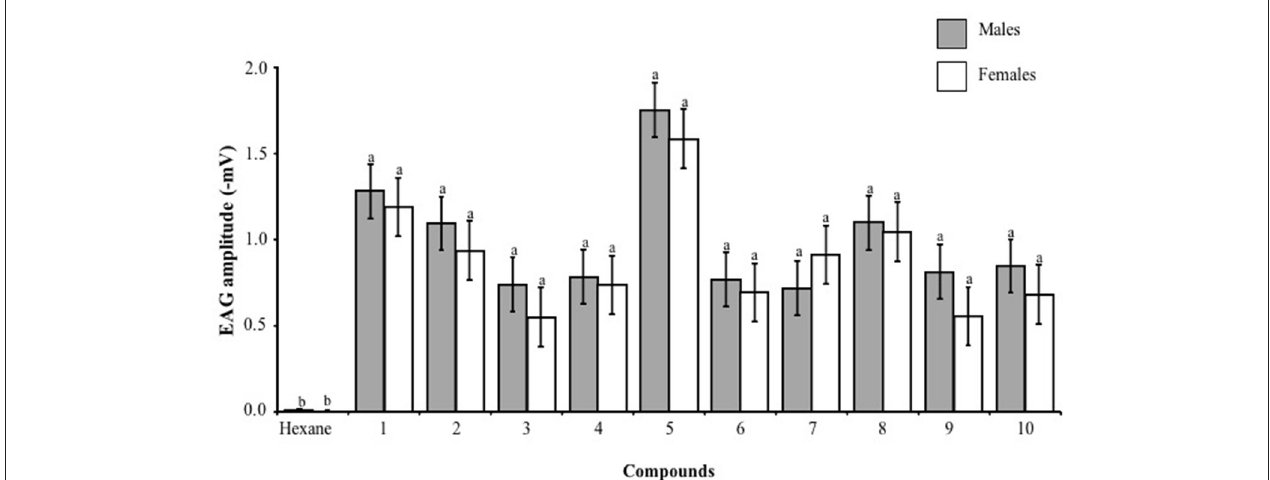
FIGURE 3 | Electrophyisological responses (–mV ± SE) of male and female Anthonomus grandis antennae to compounds identified in reproductive boll weevil-damaged cotton plants volatiles by coupled GC-EAD and GC-MS ( N = 10). Compounds: 1 = ( E )-2-methylbutanal oxime, 2 = α -pinene, 3 = ( Z )-3-hexenyl acetate, 4 = ( E )-ocimene, 5 = ( R )-linalool, 6 = ( E )-4,8-dimethyl-1,3,7-nonatriene (DMNT), 7 = methyl salicylate, 8 = ( E )-(1 R ,9 S )-caryophyllene, 9 = geranylacetone, and 10 = ( E,E )-4,8,12-trimethyl-1,3,7,11-tridecatetraene (TMTT). Same letters indicate no significant difference between male and female responses and different letters indicate significant difference between the test compounds and hexane ( P < 0.001).